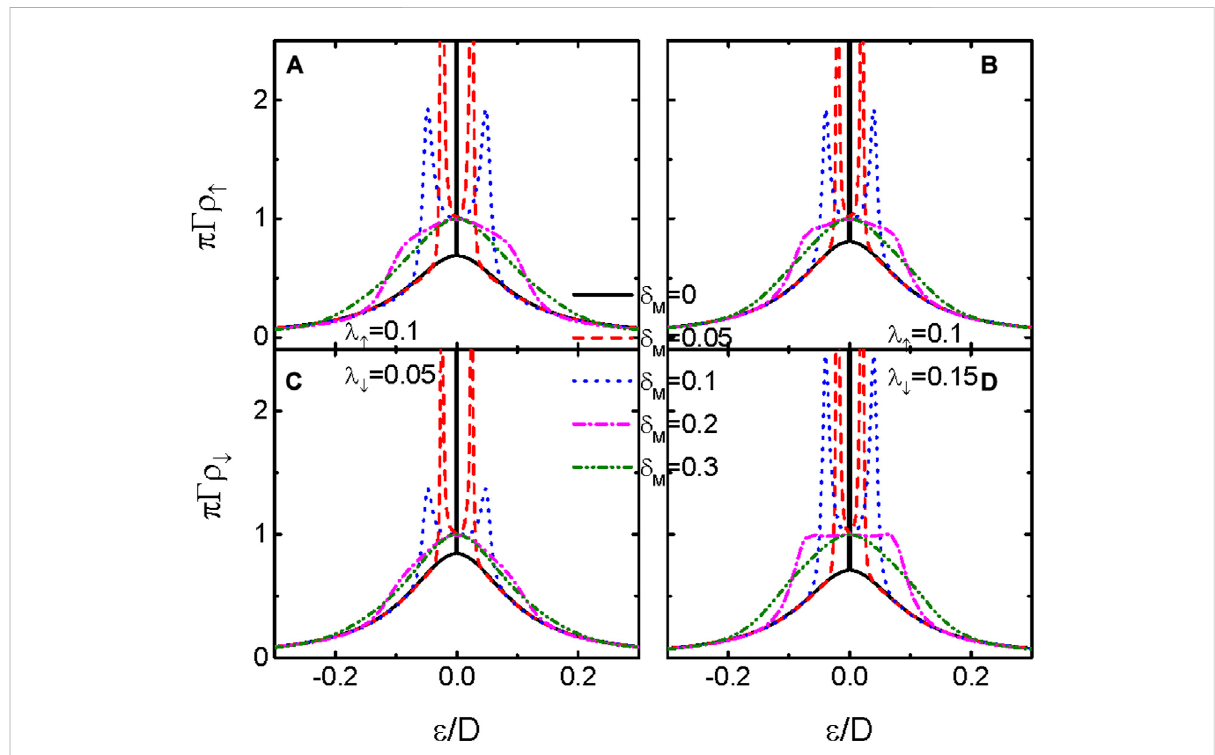
FIGURE 3 (Coloronline)Spin-resolvedLDOSvaryingwithrespecttotheelectronenergyfor fi xed λ ↑ =0.1anddifferentvaluesof δ M .Thevalueof λ ↑ in (A,C) is 0.05, and is fi xed at 0.15 in (B,D) . The other parameters are as in Figure